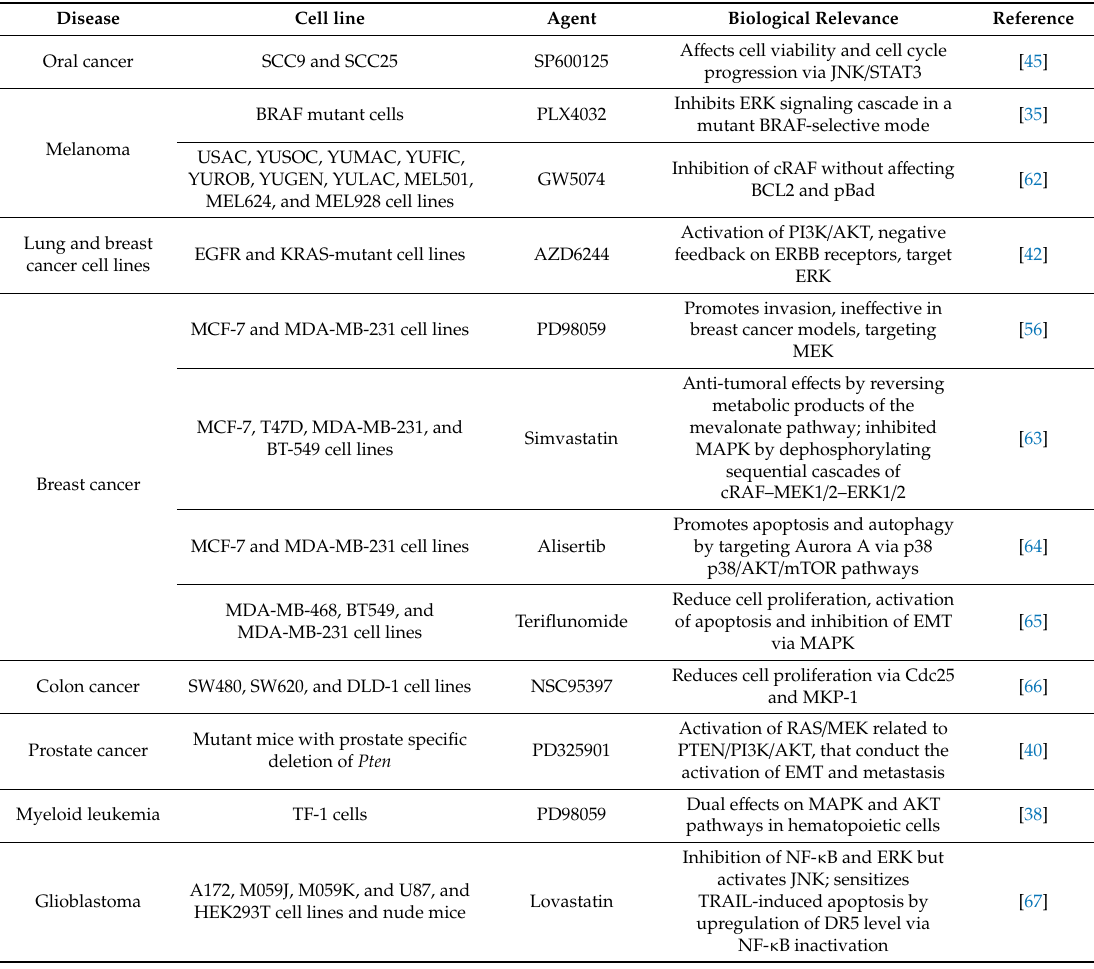
Table 1. Examples of small molecules tested as mitogen-activated protein kinase (MAPK) inhibitors on in vitro and in vivo studies. EGFR—epidermal growth factor